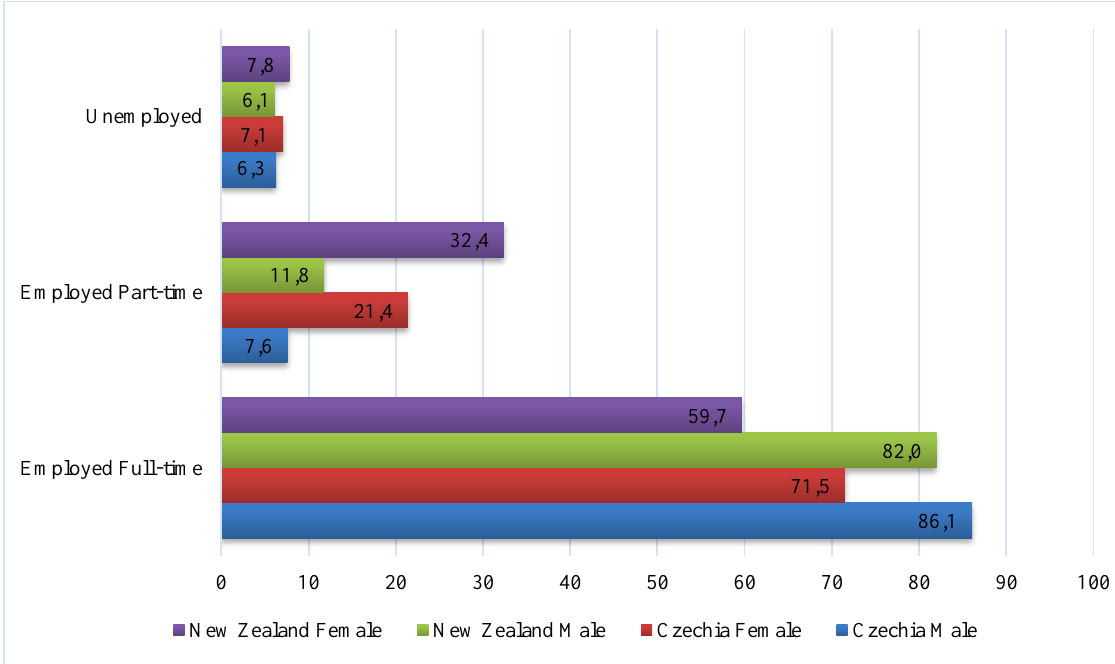
Figure 5. Labour force status of the population aged 15+ years by birthplace and gender (%), 2013